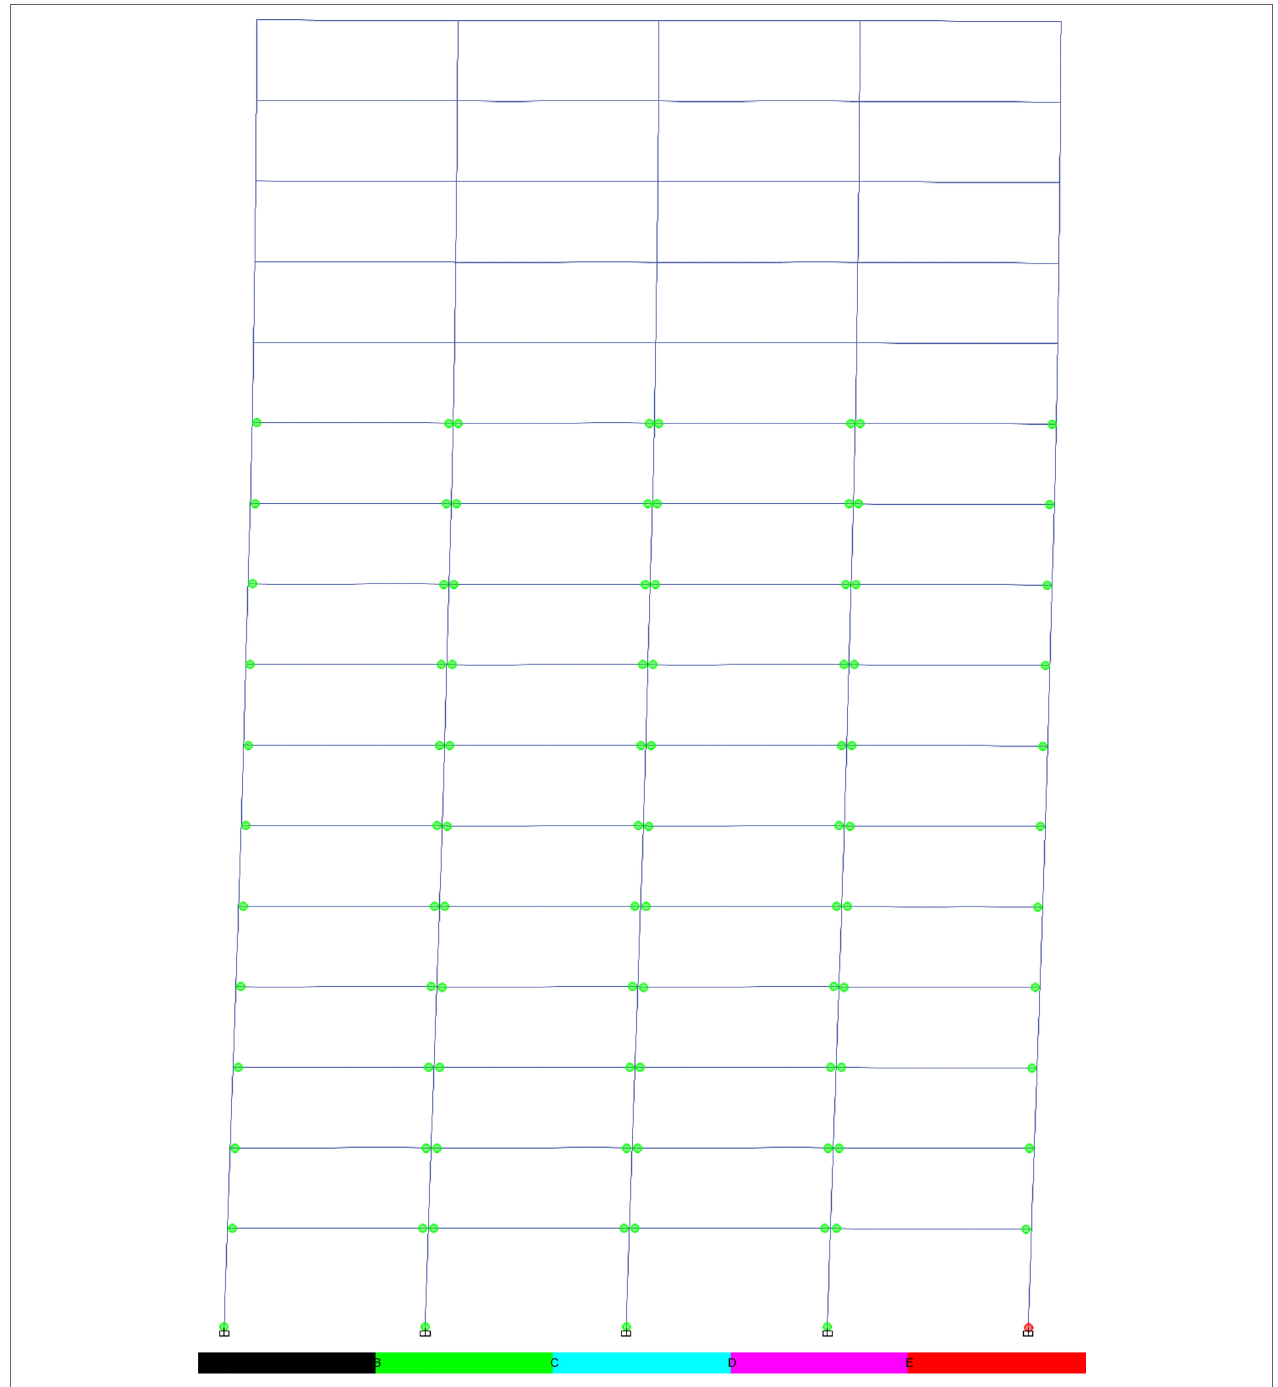
Figure 26 | Plastic hinge formation in 16-storey fully fixed frame (for cross sections, see Figure 5 and Table 4